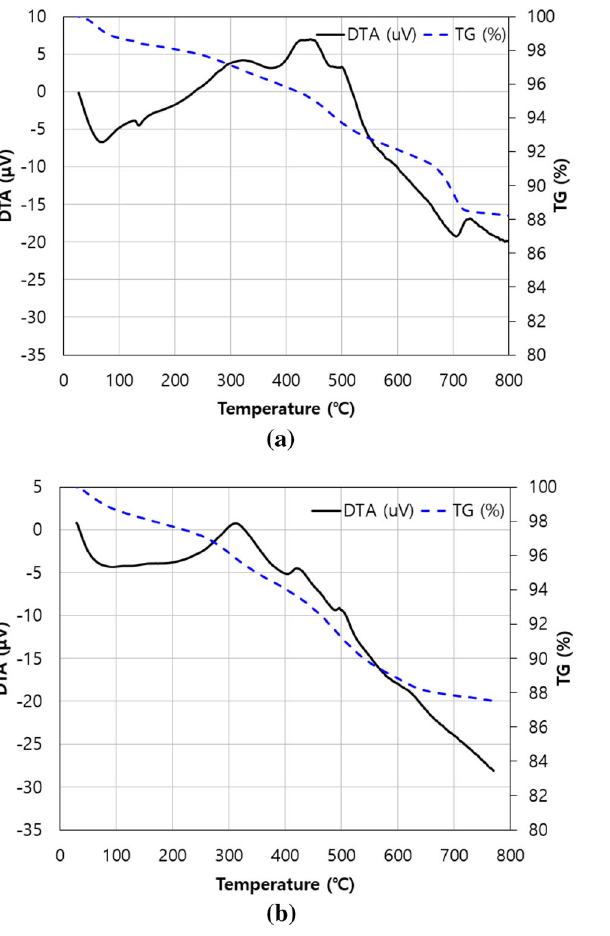
Fig. 5 Diffraction angle of 5–25 (cid:2) of XRD patterns of heat treated dredged sea soil. ( a SH, b